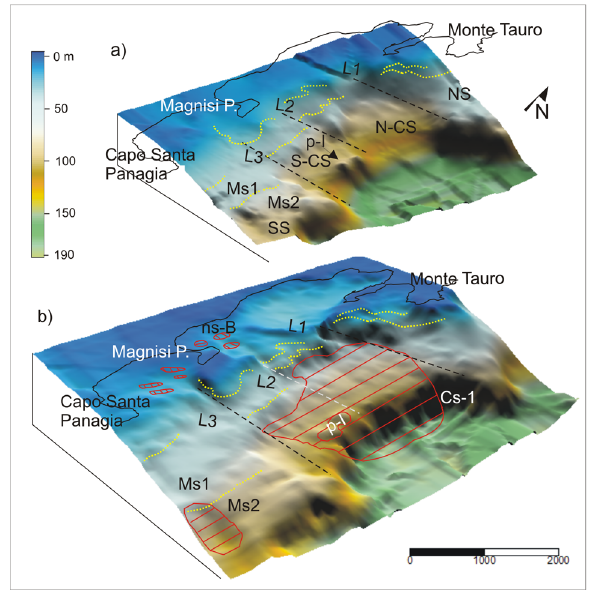
Figure 7. a) DEM of the basin bedrock showing the irregular reflec- tor R1 modified by erosion. The basin can be divided into four sec- tors: NS = northern sector, N-CS = north-central sector, S-CS = south-central sector, SS = southern sector, separated by L1, L2 and L3; p-I is a paleo-island; Ms1 and Ms2 are two marine abrasion sur- faces observed at different depths in the four sectors; dotted yellow lines are the inner edges associated to the abrasion surfaces; b) DEM of the seafloor showing the basin after deposition of the semitrans- parent Seismo Unit B deposits (delimited by the red contour line) in the north-central and south-central sectors, and in the near shore basins (ns-B) close to the Magnisi Peninsula, C-s1 is the most promi- nent scarp marking the easternmost limit of the shelf. Vertical exag- geration 3x, scale in